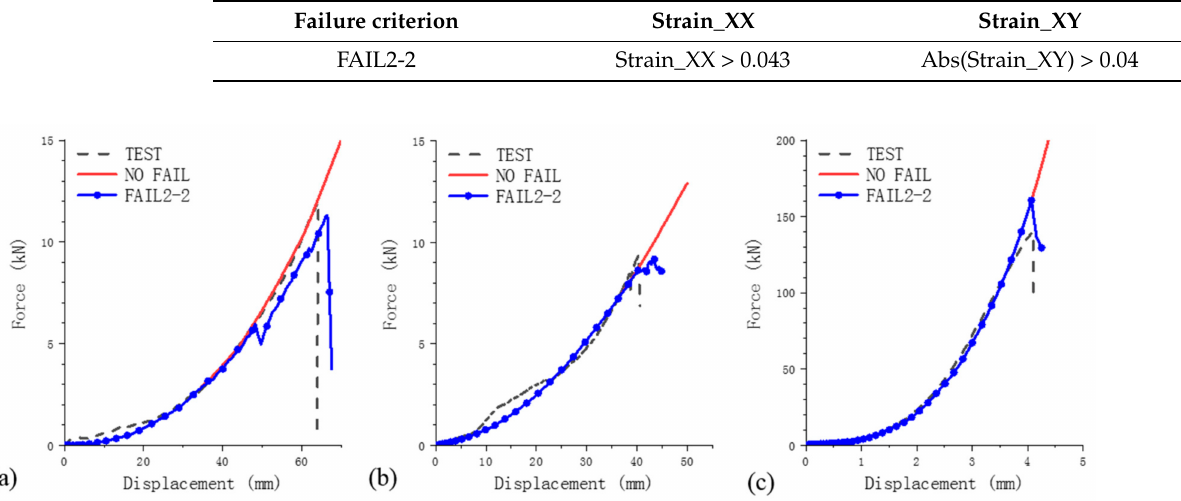
Table 4. Failure criterion considering tension strain and compression strain.